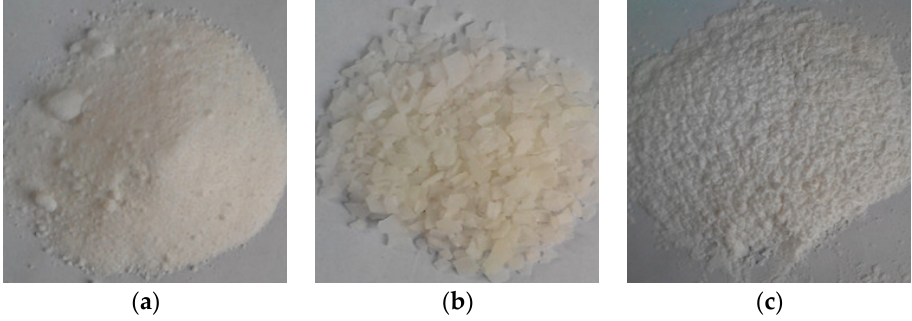
Figure 5. Dispersant appearance contrast. ( a ) Dispersant A; ( b ) Dispersant B; ( c ) Dispersant C.